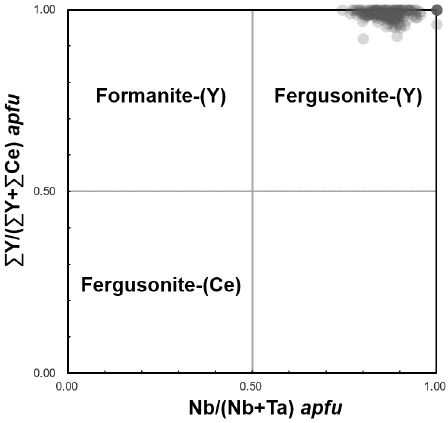
Figure 9. Compositional diagrams (atomic proportion) for the fergusonite-(Y) from the Baicao and Xiaoheiqing Xiaoheiqing deposits.